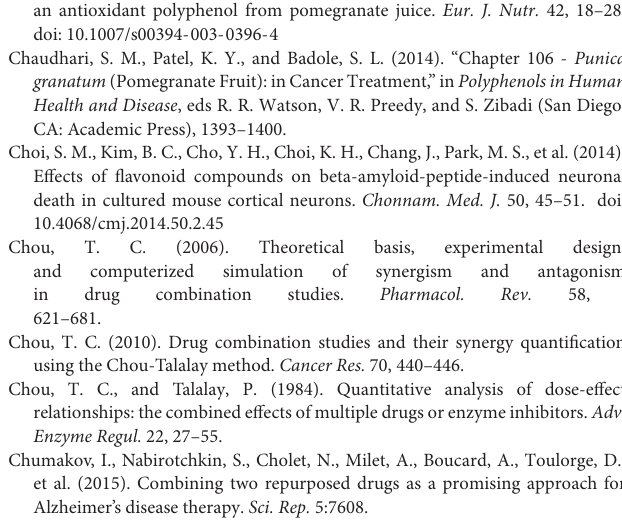
Supplementary Figure 8 | Relative ATP levels for the combination 9 (D 20 L 10 ) and its components. ATP levels for the combination 9 (D 20 L 10 ) and its constituents were determined using CellTiter Glo assay. Data are expressed as mean ± SD from four ( N = 4) independent experiments. Differences are significant at a P < 0.001 vs. vehicle control, ∗∗∗ P < 0.001 vs. A β 1 − 42 -treated control, DHA 20 µ M. Supplementary Figure 9 | Relative ATP levels for the combination 10 (D 10 L 5 ) and its components. ATP levels for the combination 10 (D 10 L 5 ) and its constituents were determined using CellTiter Glo assay. Data are expressed as mean ± SD from four ( N = 4) independent experiments. Differences are significant at a P < 0.001 vs vehicle control, ∗∗∗ P < 0.001 vs. A β 1 − 42 -treated control, DHA 10 µ M. Supplementary Figure 10 | Relative ATP levels for the combination 12 (L 20 U 5 ) and its components. ATP levels for the combination 12 (L 20 U 5 ) and its constituents were determined using CellTiter Glo assay. Data are expressed as mean ± SD from four ( N = 4) independent experiments. Differences are significant at a P < 0.001 vs. vehicle control, ∗∗∗ P < 0.001 vs. A β 1 − 42 -treated control, LUT 20 µ M and UA 5 µ M. Supplementary Figure 11 | Relative ATP levels for the combination 13 (L 10 U 5 ) and its components. ATP levels for the combination 13 (L 10 U 5 ) and its constituents were determined using CellTiter Glo assay. Data are expressed as mean ± SD from four (N = 4) independent experiments. Differences are significant at a P < 0.001 vs. vehicle control, ∗∗∗ P < 0.001 vs. A β 1 − 42 -treated control, LUT 10 µ M and UA 5 µ